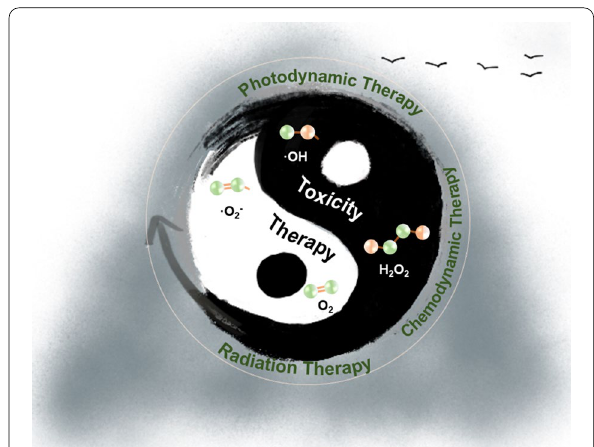
Fig. 1 Schematic representation of the the potential of transforming toxicity to therapy